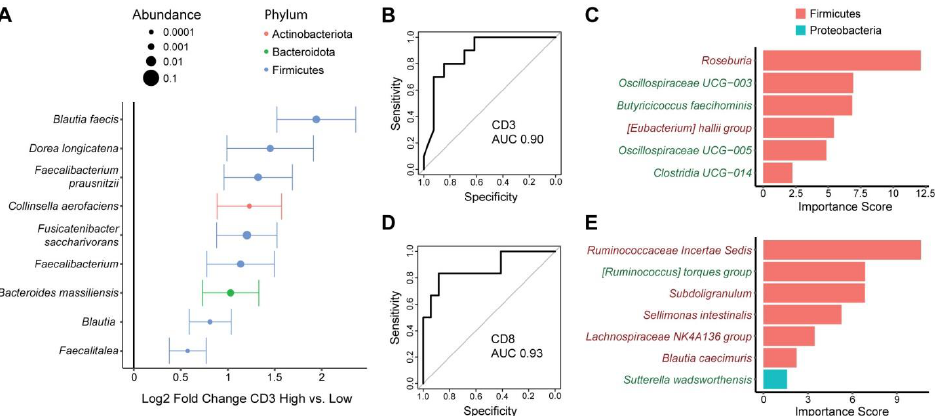
Figure 4. Tumor and fecal microbes are associated with tumor T cell infiltration. ( A ) ASVs present in tumor core tissue that were differentially abundant between tumors with high vs. low CD3+ T cell infiltration are shown. Effect size is represented as log2 fold change ± standard error, with dot size proportional to mean relative abundance of the ASV. Color represents phylum. ( B – E ) Random forests classifiers that predict high vs. low CD3+ ( B , C ) or CD8+ ( D , E ) T cell infiltration into tumors using fecal microbiota. Classifier performance is shown by receiver operating characteristic curves with area under the curve (AUC). Microbes included in the CD3 and CD8 classifiers are shown in ( C ) and ( E ), respectively, with their importance scores. Names colored in green were enriched in subjects with high T cell infiltration and names colored in red were depleted.